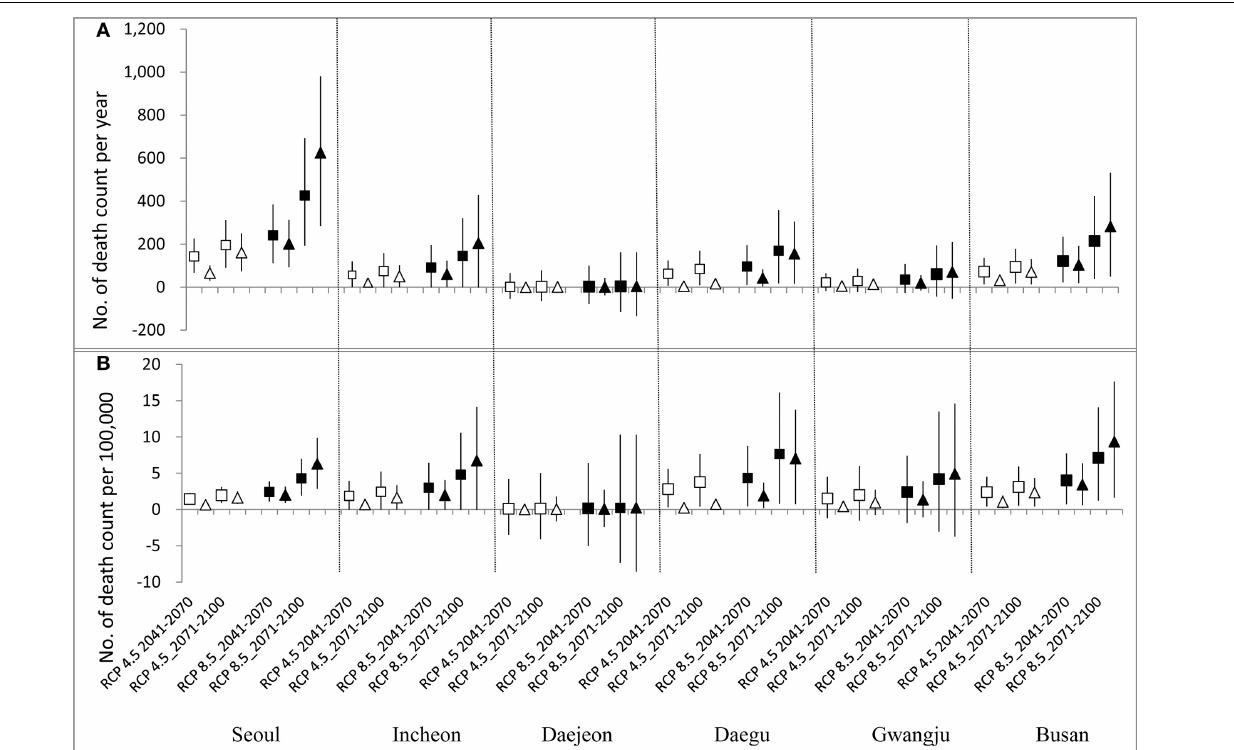
triangle indicate results from “shitted” and “added” effect based on RCP 4.5 scenario and black square and triangle indicate results from “shitted” and “added” effect based on RCP 8.5, respectively; vertical bars indicate 95% confidence